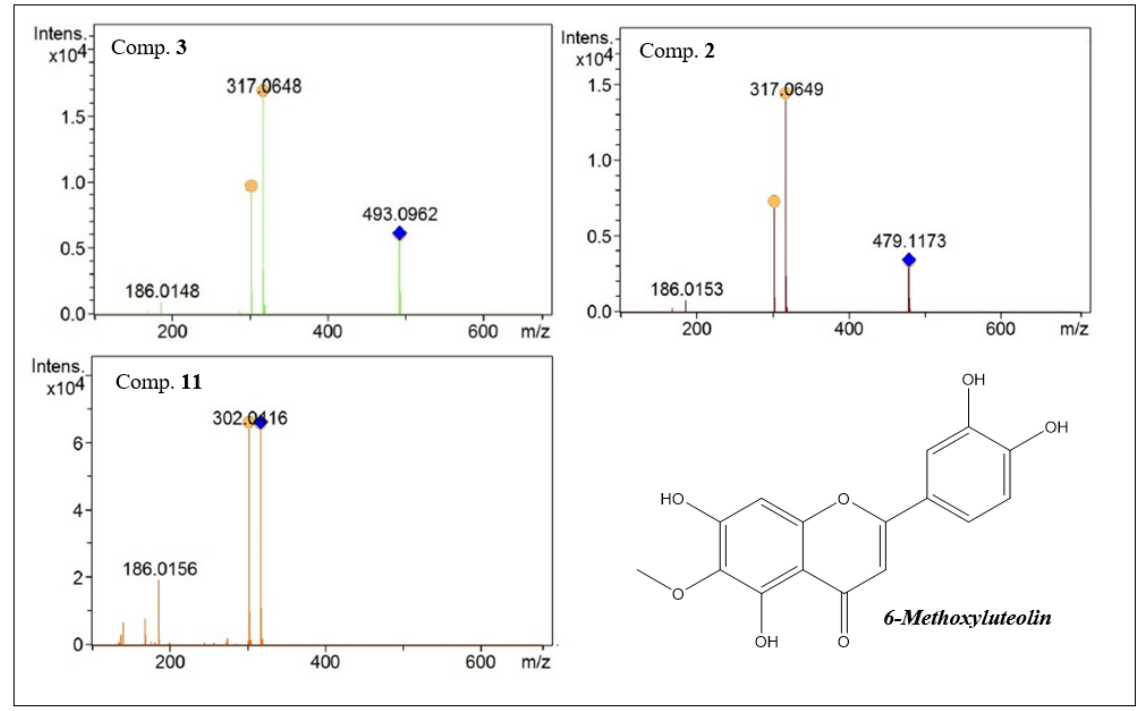
Figure 11. MS 2 spectra of flavones with methoxy luteolin-like aglycones present in the ethanolic extract of F. chica leaves.